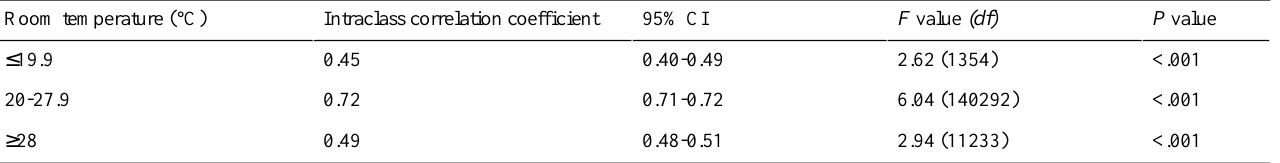
Table 2. Intraclass correlation coefficients between HEARThermo and infrared skin